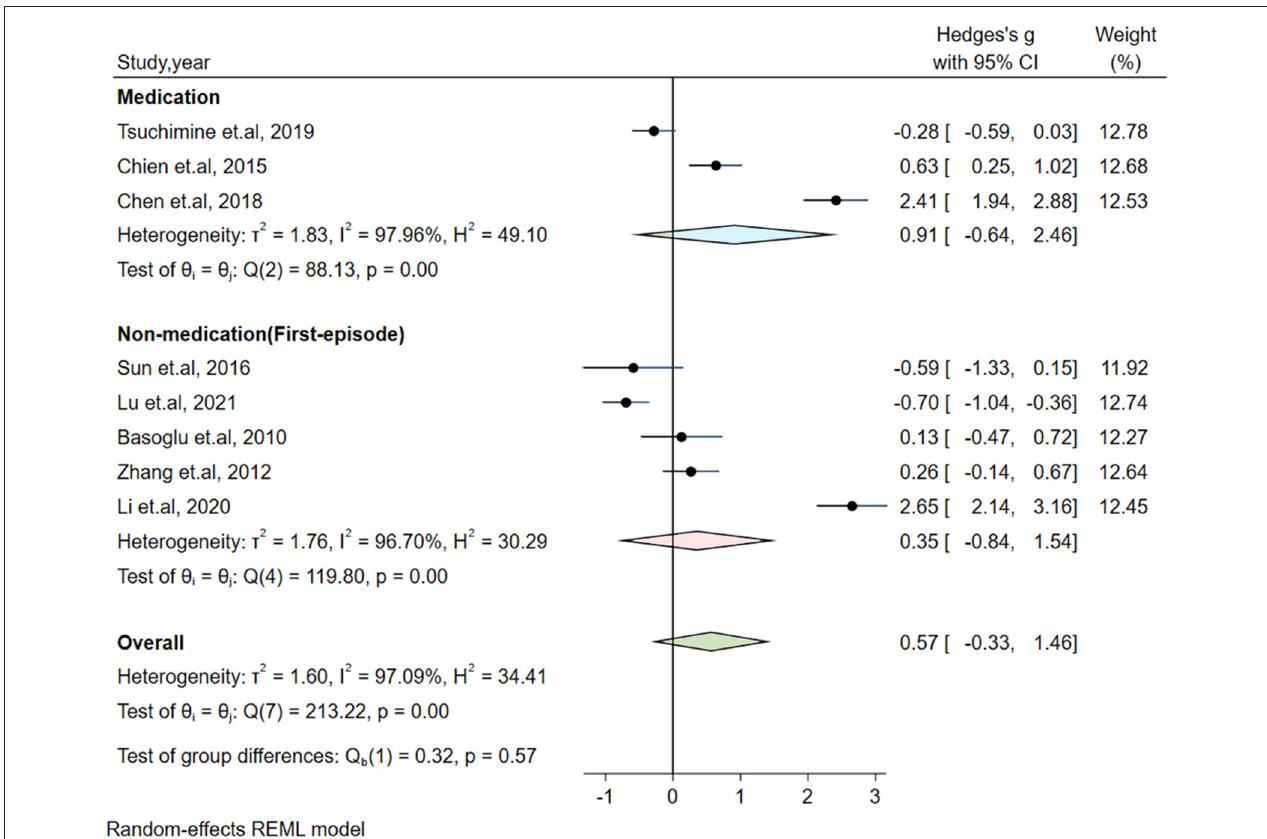
FIGURE 5 | Subgroup analysis of plasma orexin-A levels in patients with schizophrenia compared to healthy controls (based on